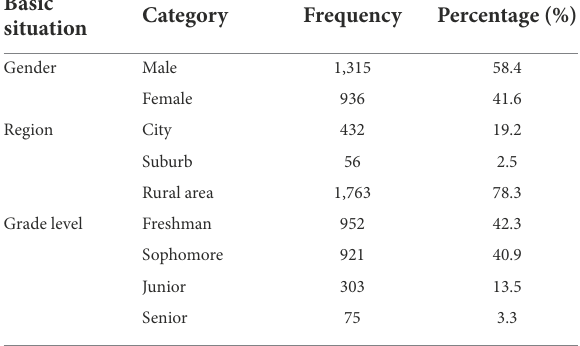
TABLE 1 Demographic